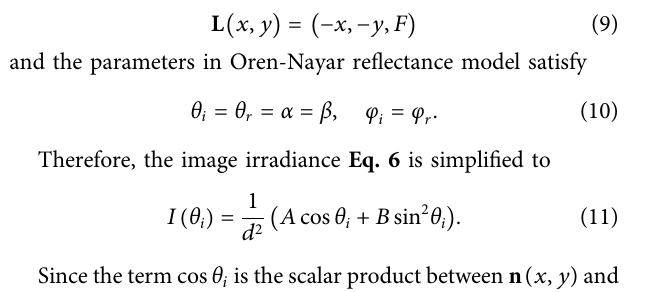
Frontiers in Physics |